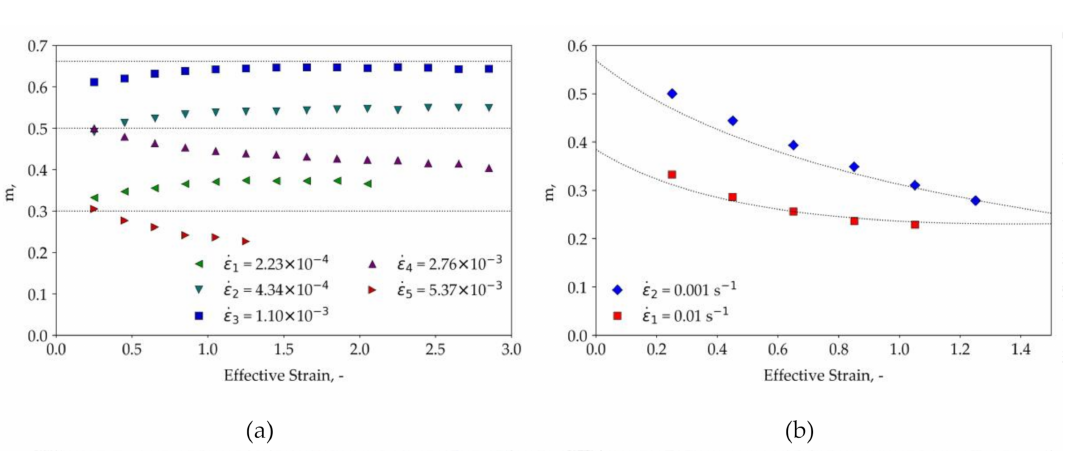
Figure 13. The relations of m value on the e ff ective strain at di ff erent strain rates: ( a ) for the sigmoidal material model (Equation (5)); ( b ) for the material model described by Equation